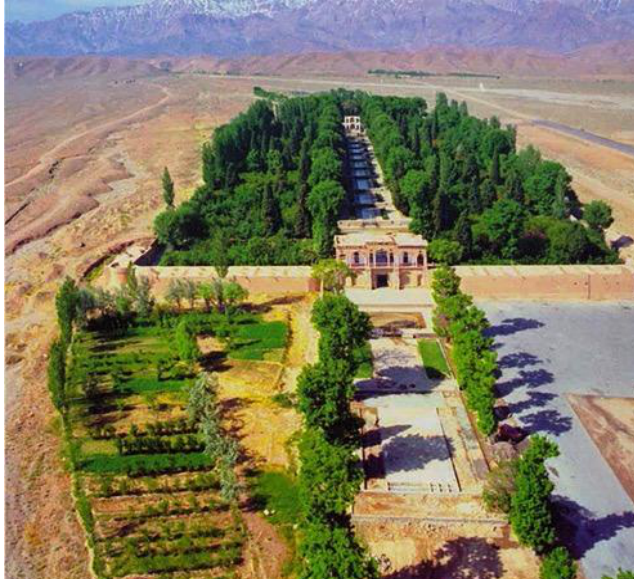
Figure 3. Aerial view of Shahzadeh-Mahan Garden in the middle of desert, Kerman, ( ICHHTO The Office of Cultural Heritage of Iranian Cultural